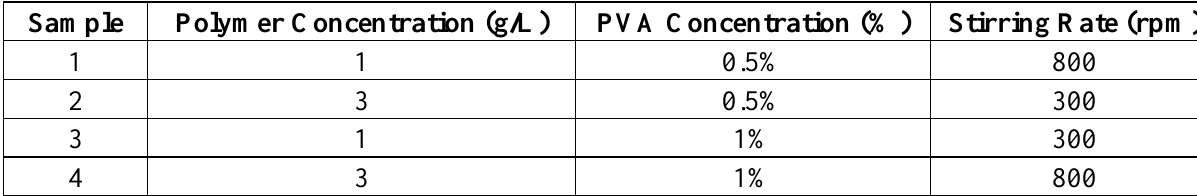
Table 1. The varying processing conditions (amount of surfactant, polymer concentration and stirring rate) used for the synthesis of P(3HB)